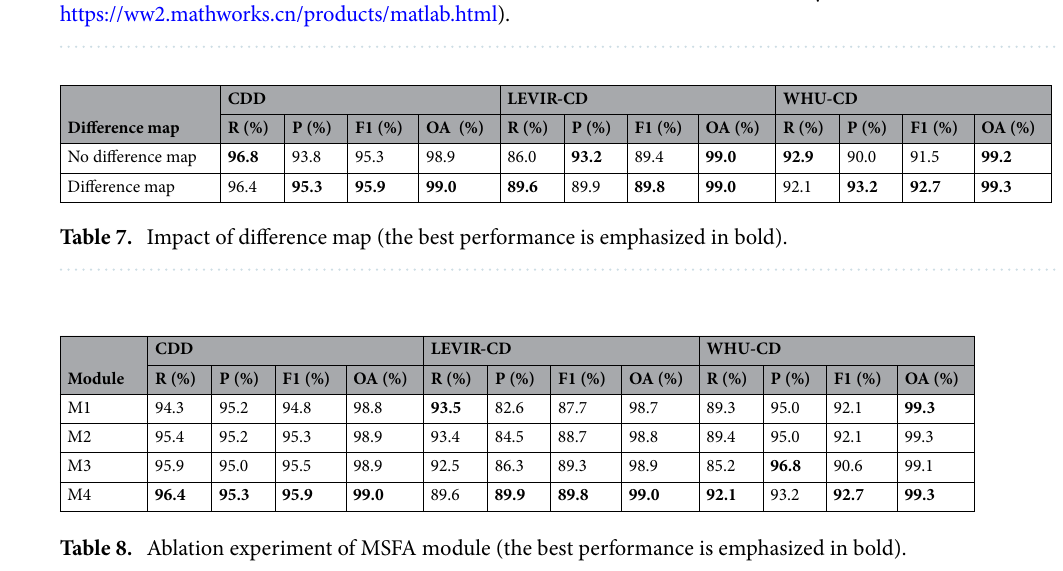
Figure 10. Setting different loss function proportional ablation experiments on three datasets, they should be listed as: ( a ) CDD dataset; ( b ) LEVIR-CD dataset; ( c ) WHU-CD dataset (created by “matlab R2019a” url: https:// ww2. mathw orks. cn/ produ cts/ matlab. html).